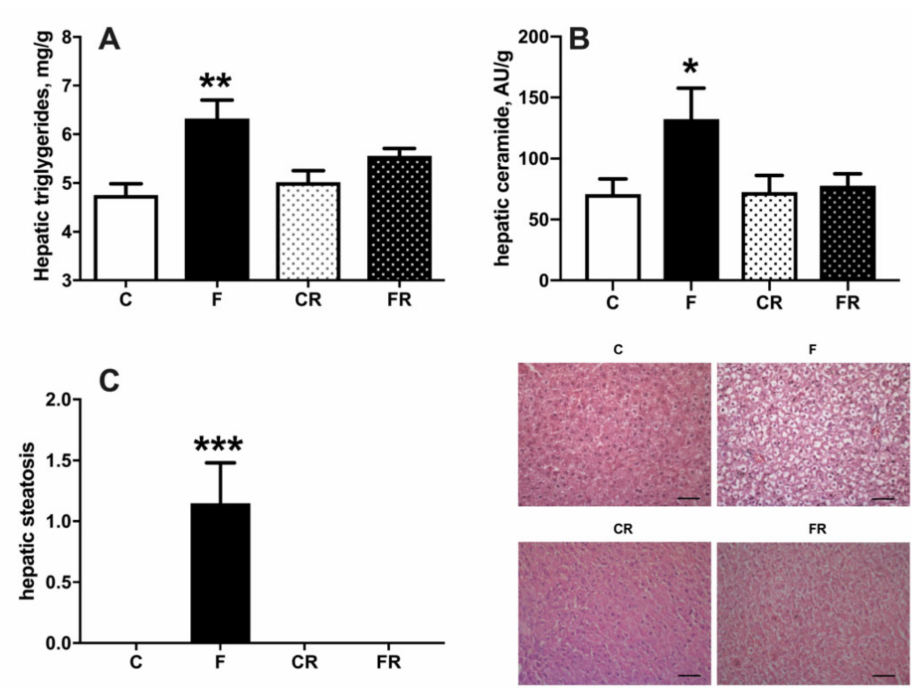
Figure 6. Triglycerides ( A ), ceramide ( B ), and degree of steatosis ( C ), in liver from control (C), fructose (F), control rescue (CR), and fructose rescue (FR) rats. Values are the means ± SEM of eight different rats. * p < 0.05, ** p < 0.01, *** p < 0.001 compared to respective control (one-way ANOVA followed by Tukey post-test). Scalebar = 50 µ